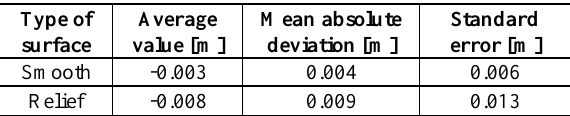
Table 4. Accuracy